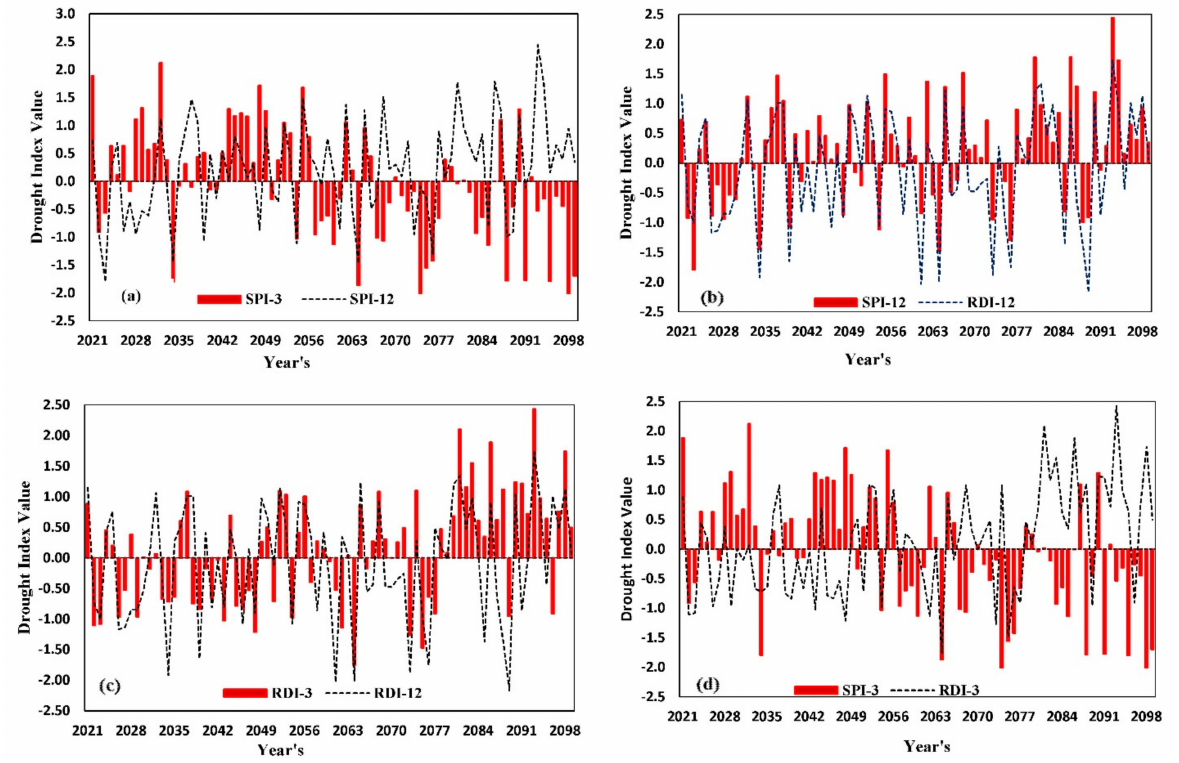
Figure 2. SPI and RDI drought trends at 3 months and 12 months under RCP